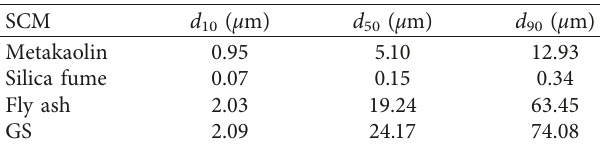
Figure 2: XRD patterns of all supplementary cementing materials (1: quartz, 2: feldspars, 3: anhydrite, 4: maghemite, 5: gehlenite, 6: cristobalite, 7: illite, and 8: calcite). Table 2: Characteristic values of the grain size analysis of the